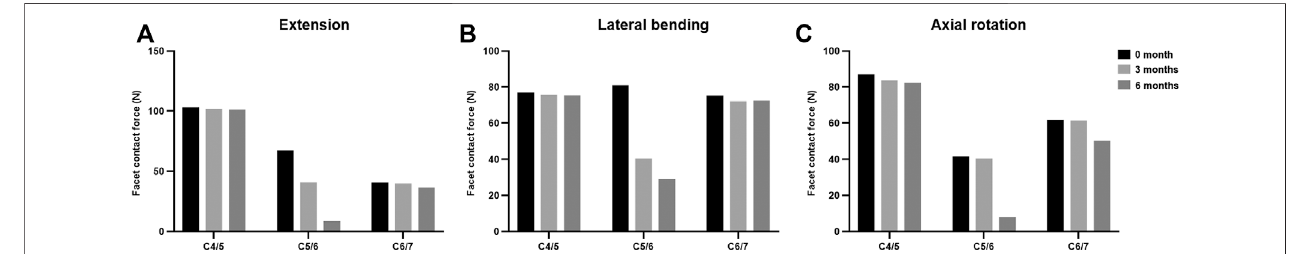
FIGURE 4 | The facet contact force at the surgical and adjacent levels at different fusion stages in (A) extension, (B) lateral bending, and (C) axial rotation.